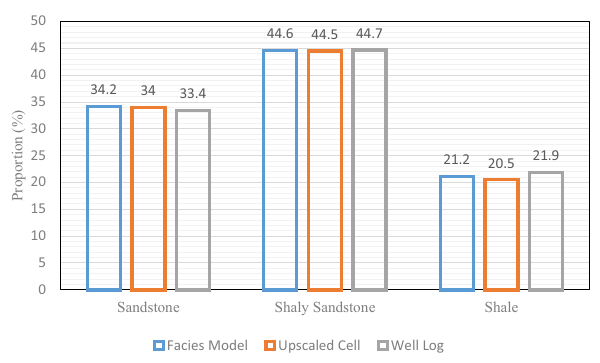
Fig. 9 Comparison of the facies percentages of well log analysis, upscaled logs, and facies model